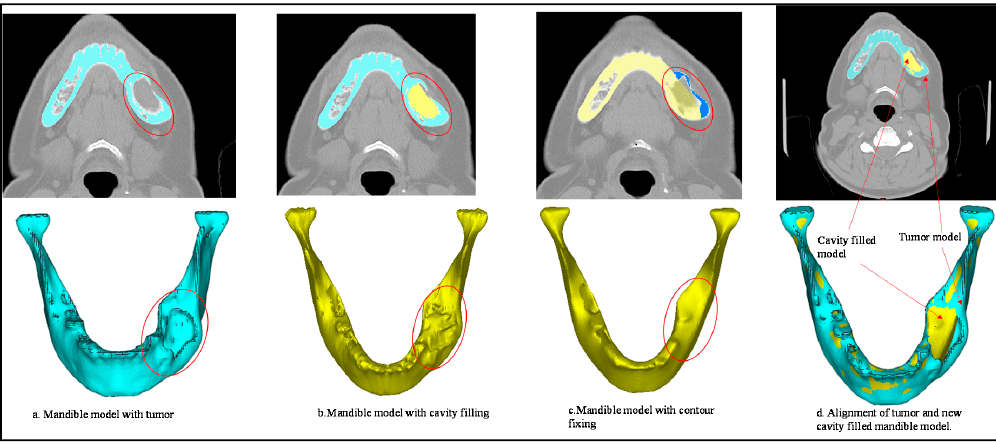
Figure 5. Sequential steps involved in the reconstruction of the mandible using cavity-filled technique.